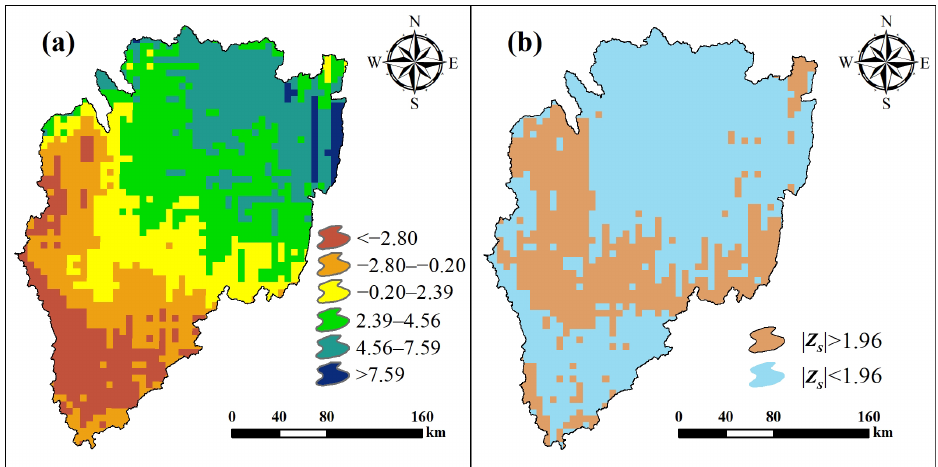
Figure 5. Trend analysis of precipitation; ( a ) Sen’s Slope value map; ( b ) the MannKendall test value